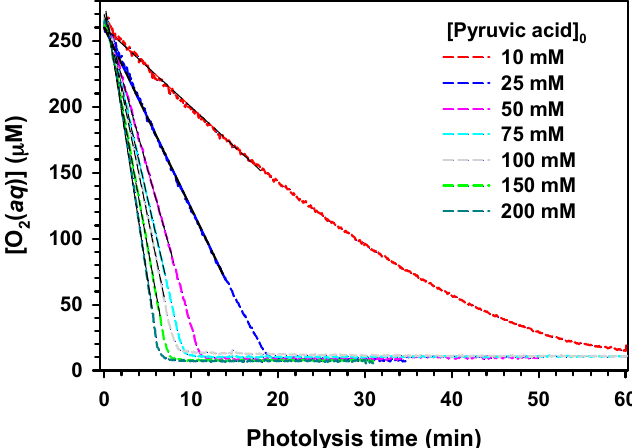
Figure 1. Dissolved oxygen consumption during the photolysis at λ ≥ 305 nm (incident photon rate: I 0 = 1.13 × 10 − 5 Einstein L − 1 s − 1 ) of 10.0 ≤ [PA] 0 ≤ 200.0 mM (as color coded in the figure) at pH 1.0 and 25 ◦ C under continuous air sparging of 30.0 mL min − 1 . The absorbed photon rates are I a,10 mM = 7.80 × 10 − 6 Einstein L − 1 s − 1 for [PA] 0 = 10 mM, I a,25 mM = 1.07 × 10 − 5 Einstein L − 1 s − 1 for [PA] 0 = 25 mM; and I a,50–200 mM = 1.13 × 10 − 5 Einstein L − 1 s − 1 for 50 ≤ [PA] 0 ≤ 200 mM. Representative nonlinear fittings for the zero-order reaction are provided with thin black dash traces.